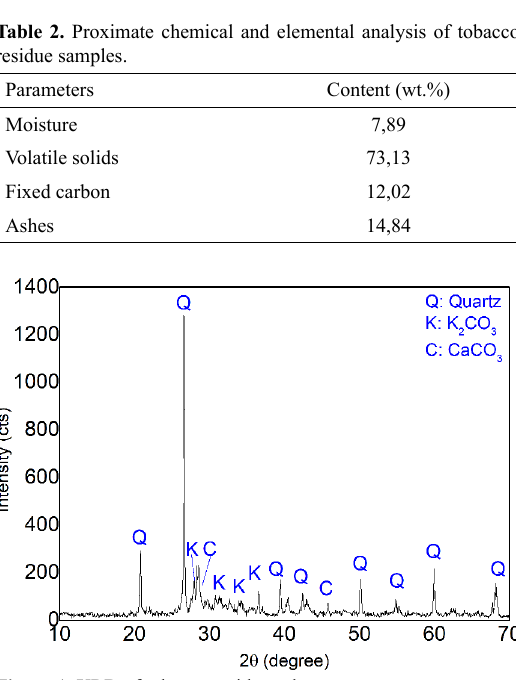
Figure 1. XRD of tobacco residue ash.